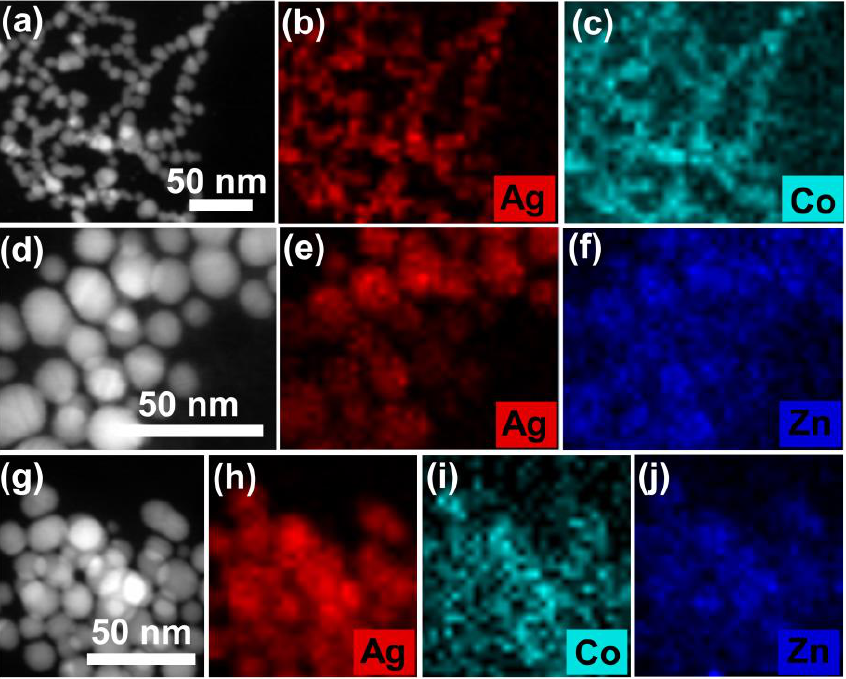
Figure 6. Elemental mappings of PVP-AgNPs in the presence of ( a – c ) 2 mg/L Co 2+ , ( d – f ) 50 g/L Zn 2+ , ( g – j ) mixed solution of 2 mg/L Co 2+ and 50 g/L Zn 2+ .